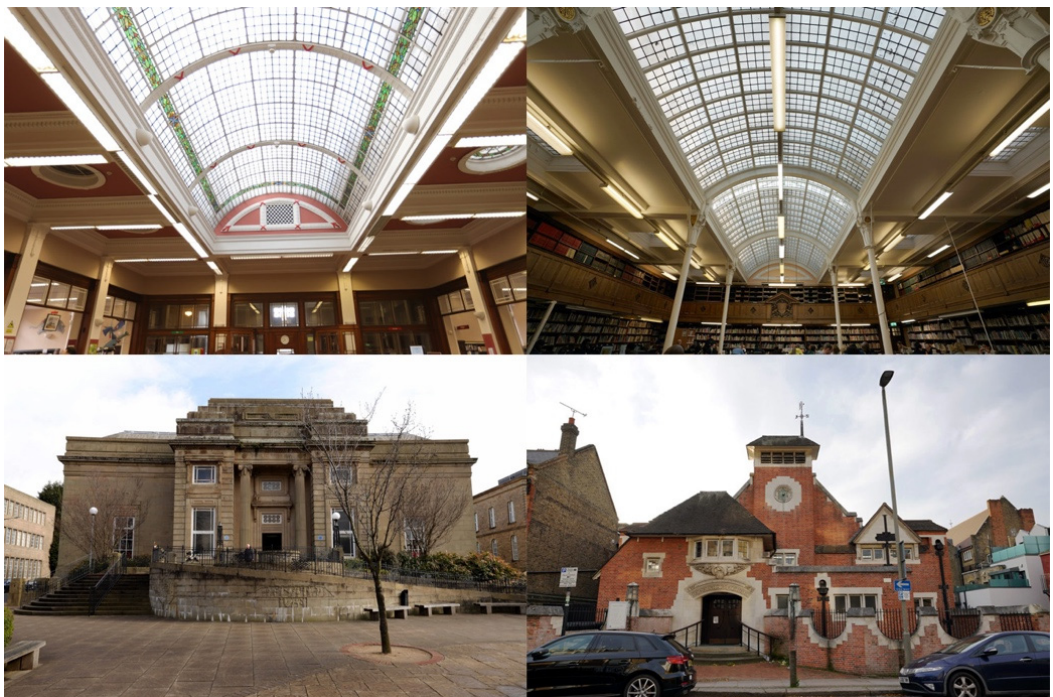
Figure 1. Left: Burnley Library Facade and Interior, A Race, 1930 Right: Battersea Reference Library Façade and interior, H. Hyams, 1924.